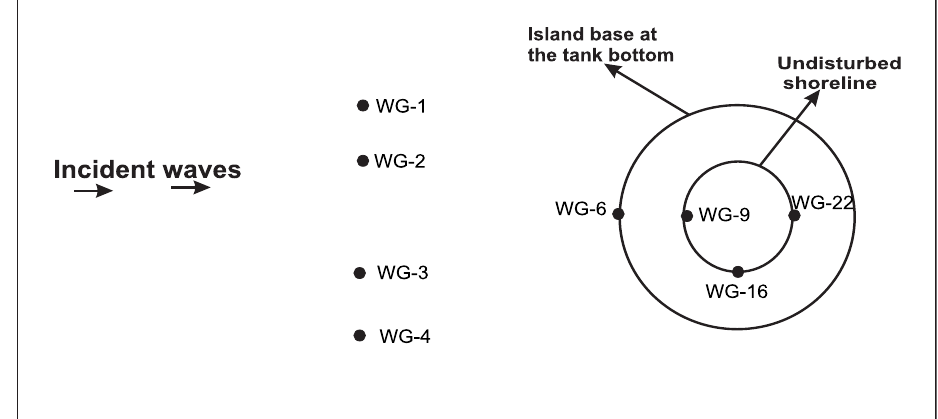
Figure 8. The location of wave